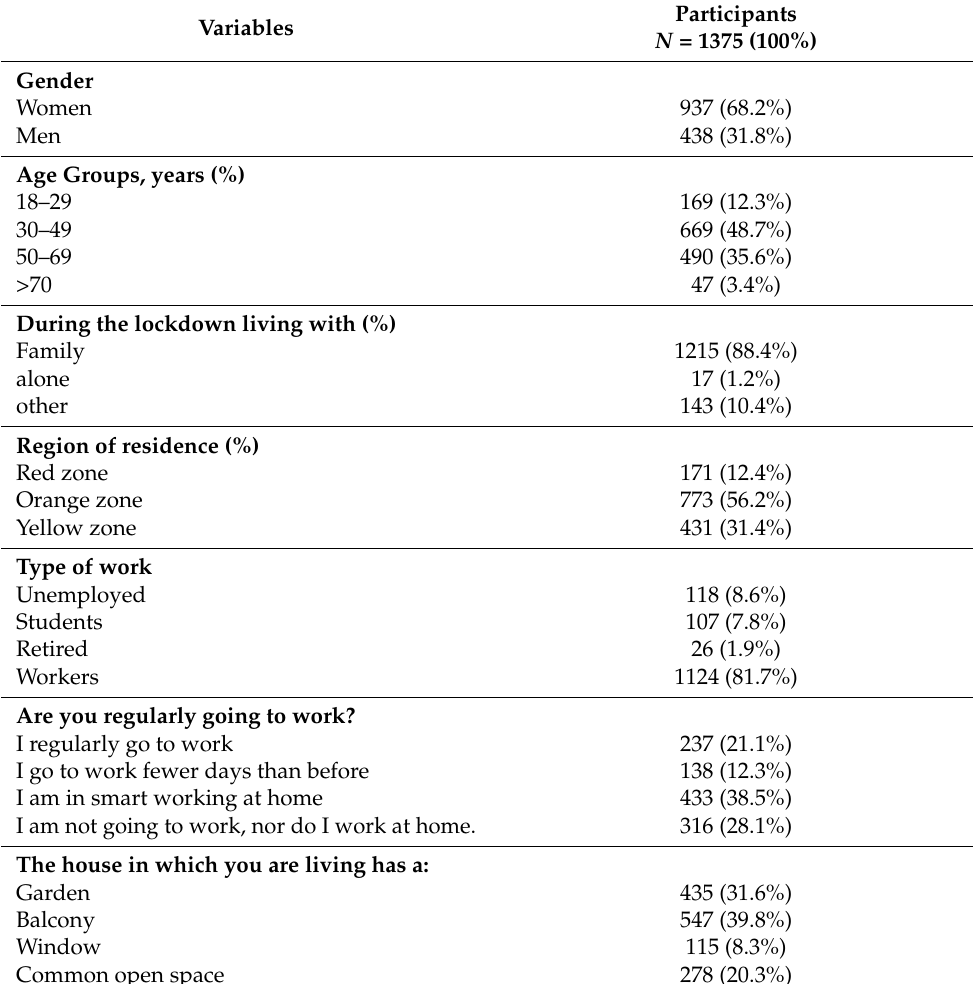
Table 1. Demographics and selected characteristics of the